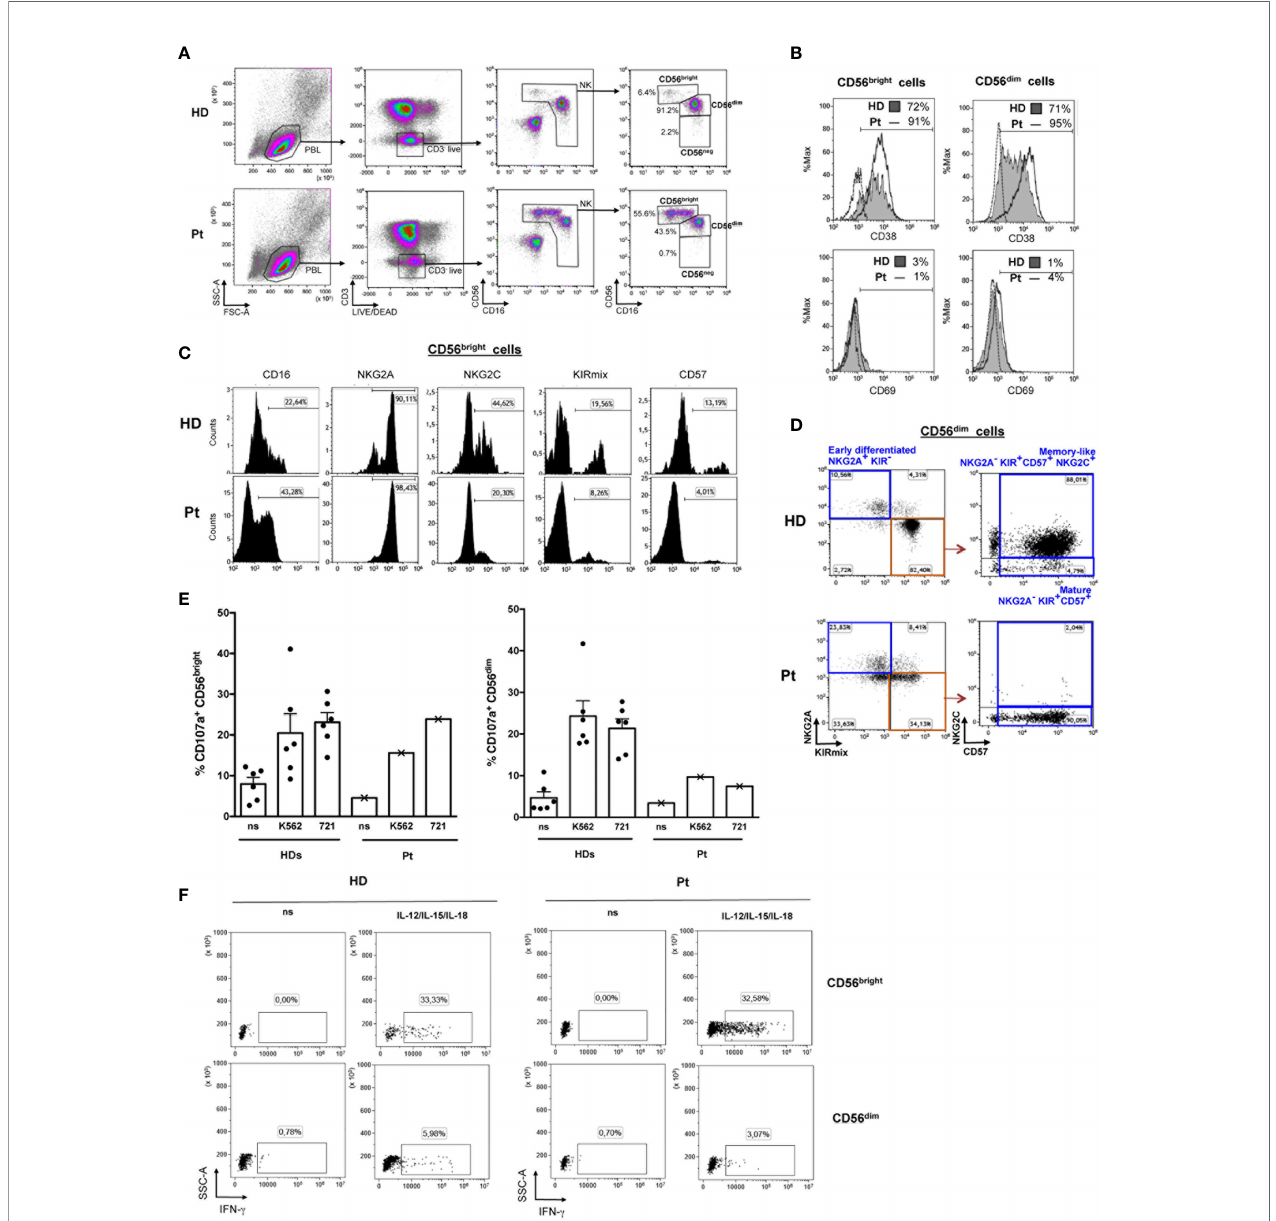
FIGURE 2 | Flow cytometry-based analysis of NK cell subsets. (A) The gating strategy used to identify NK cells among PBMCs and measure the frequencies of CD56 bright , CD56 dim , and CD56 neg subsets is shown for the patient (Pt) and a representative HD. (B) The frequency of CD38 + and CD69 + cells in CD56 bright and CD56 dim NK cells from the patient (open histograms) and a representative HD ( fi lled gray histograms) is shown together with control IgG signal (dashed lines). (C) Histograms depict expression of CD16, NKG2A, NKG2C, KIR (KIRmix: KIR2DL1/S1/S3/S5 and KIR2DL2/L3/S2), and CD57 on CD56 bright cells gated as shown in panel (A) . (D) The gating strategy used to identify different maturation subsets (Early differentiated, Mature, and Memory-like) on the basis of NKG2A, NKG2C, CD57 and KIR expression in CD56 dim cells gated as described in panel (A) is shown for the Pt and a representative CMV-seropositive HD. (E) Bar plots represent pattern of CD107a expression measured by fl ow cytometry on gated CD56 bright (left) and CD56 dim (right) NK cells of the WHIM-like patient and HDs following 6 hours culture of PBMCs with and without (non stimulated, ns) K562 or 721.221 (721) cell targets. The mean ± SD of 6 HDs is reported. (F) Dot plots depict intracellular IFN- g expression in gated CD56 bright and CD56 dim NK cells following 20 hours culture in the presence or absence (ns) of IL-12, IL-15, and IL-18 of PBMCs derived from a representative HD and the WHIM-like patient. The percentage of IFN- g + cells is